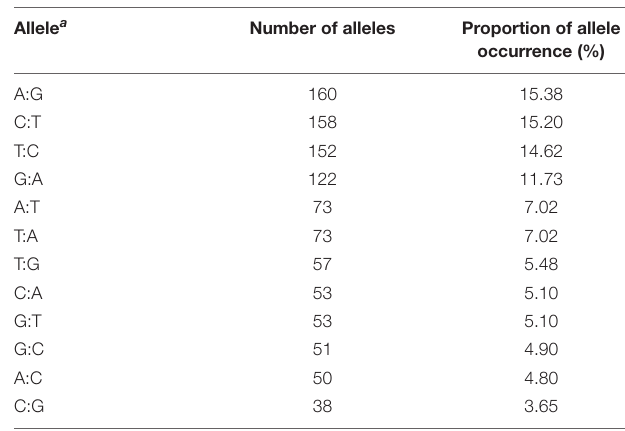
TABLE 3 | Single-nucleotide polymorphism statistics in filtered data showing the number of alleles and the rate of allele occurrence. Allele a Number of alleles Proportion of allele